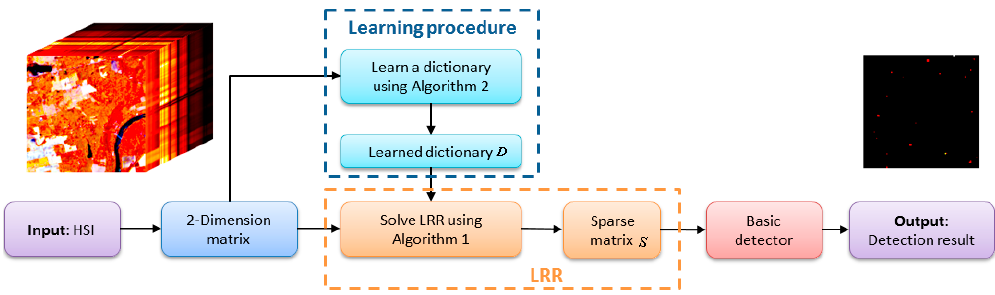
Figure 1. Framework of the proposed method.